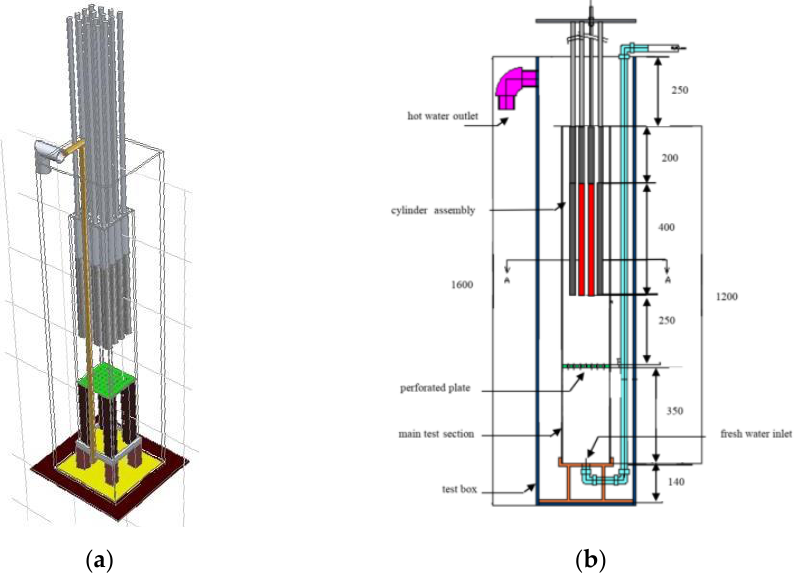
Figure 1. Sketch of experiment test section ( a ) and its vertical cross-section ( b ).